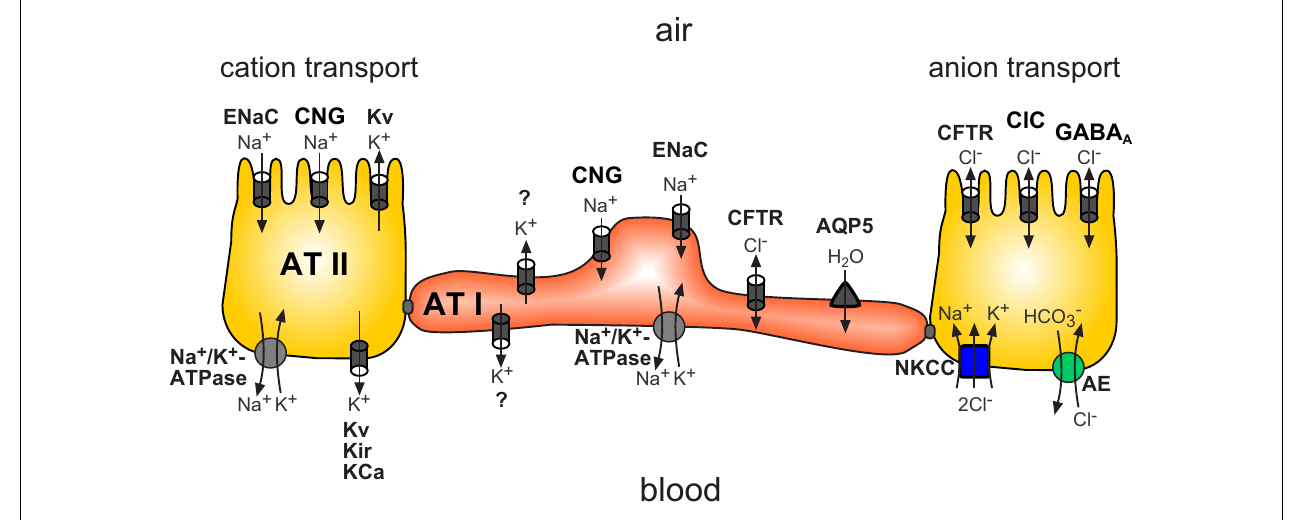
FIGURE 5 | Scheme illustrating the main ion transport proteins of alveolar epithelial cells (alveolar type I:AT I in red and alveolar type II:AT II in yellow) participating in transepithelial ion transport. Findings depicted in this figure are primarily derived from studies investigating the expression/presence of the molecules. ENaC, epithelial Na + channel; CNG, cyclic-nucleotide-gated channel; Kv, voltage-gated potassium channels; Na + /K + -ATPase, sodium/potassium ATPase; Kir, inward rectifying K + channel;